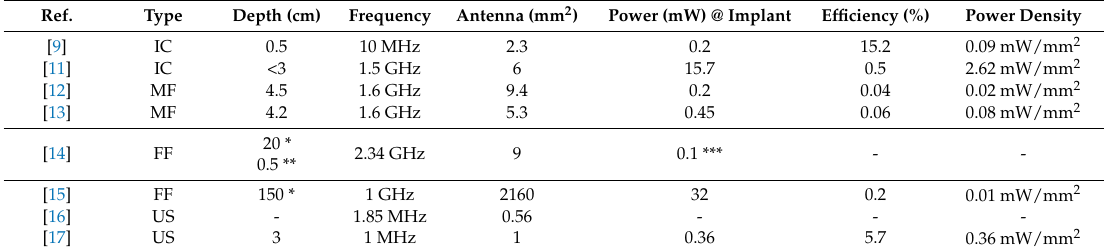
Table 1. Summary of implantable devices’ wireless power transfer (WPT) link characteristics.